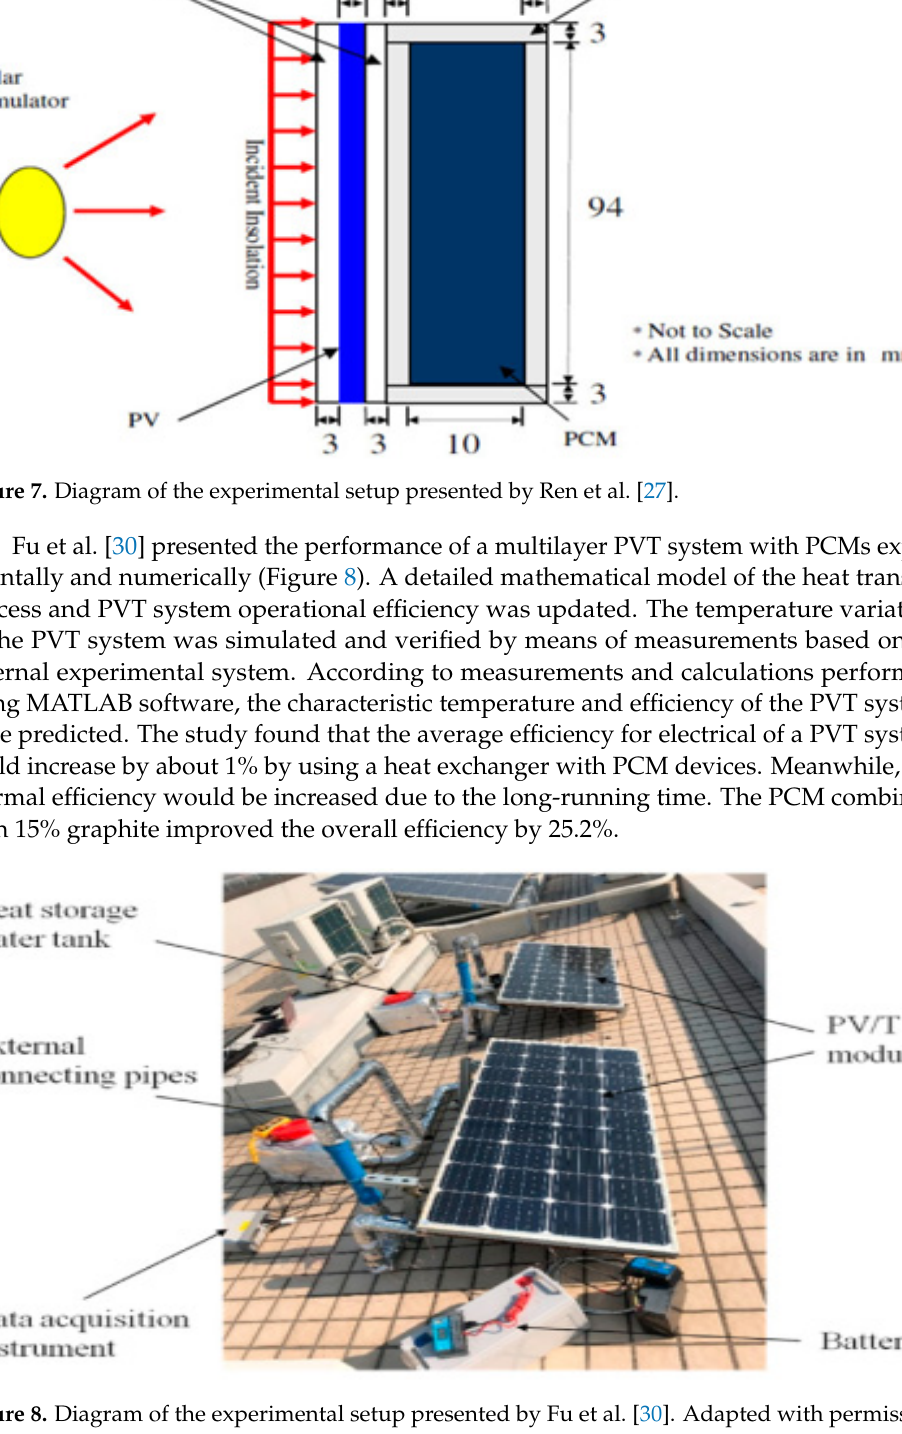
Figure 8. Diagram of the experimental setup presented by Fu et al. [30]. Adapted with permission from Elsevier.